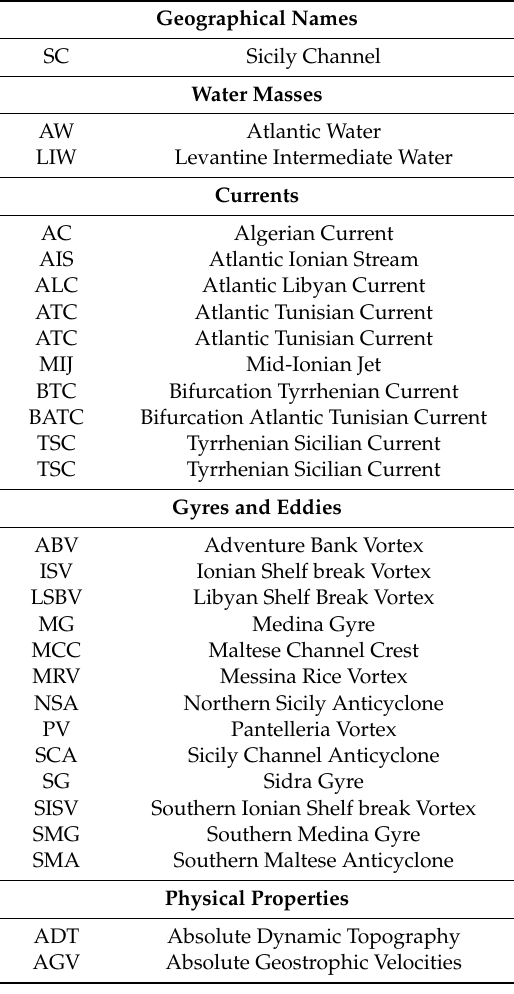
Table 1. List of acronyms used in this